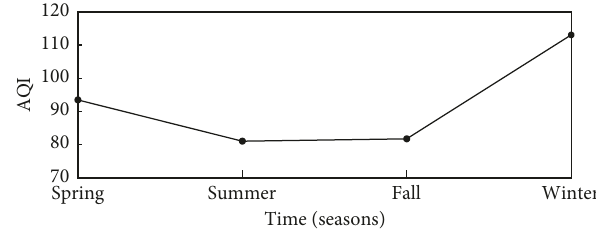
Figure 3: Seasonal AQI variation in Jiangsu Province in the period 2013–2017.